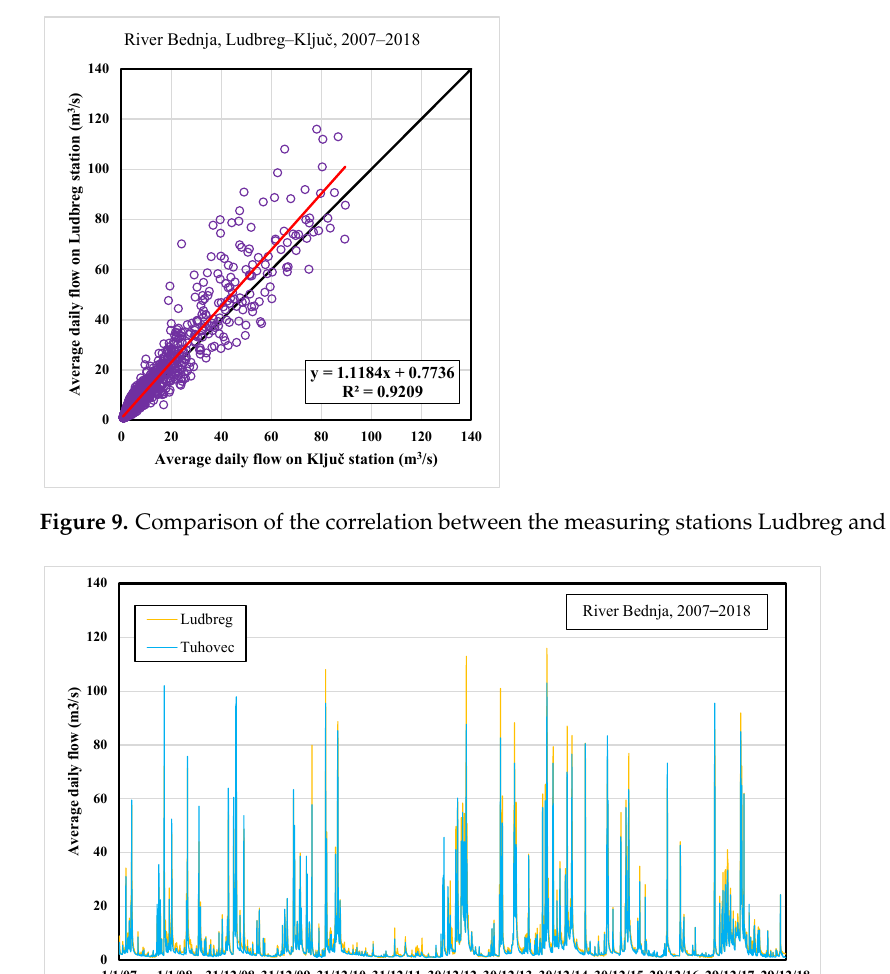
Figure 8. Comparison of the average daily flows for the measuring stations Ludbreg and Klju č .